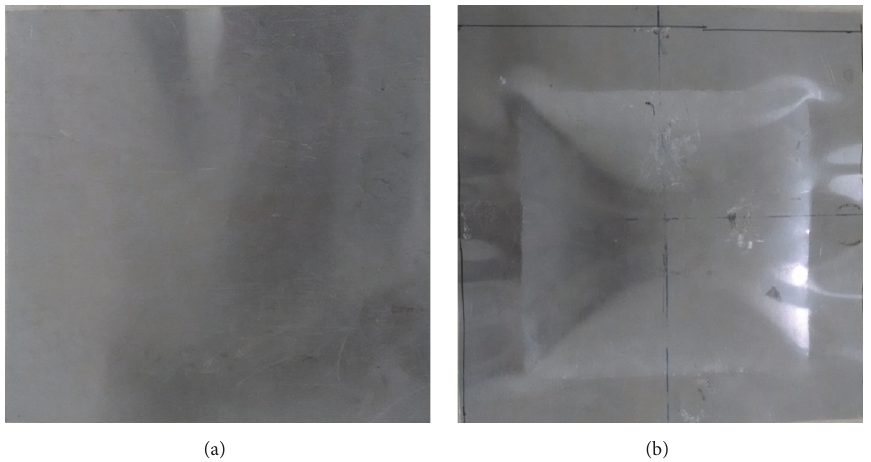
Figure 16: (a) Initial test specimen. (b) Deformed shape due to shock